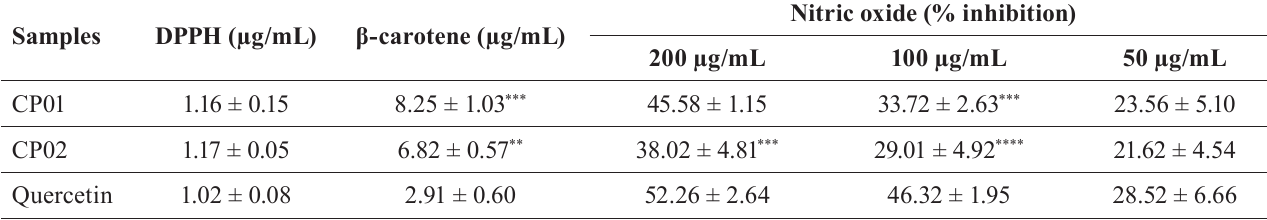
TABLE III - Antioxidant capacity of glycolic extracts of Cecropia pachystachya